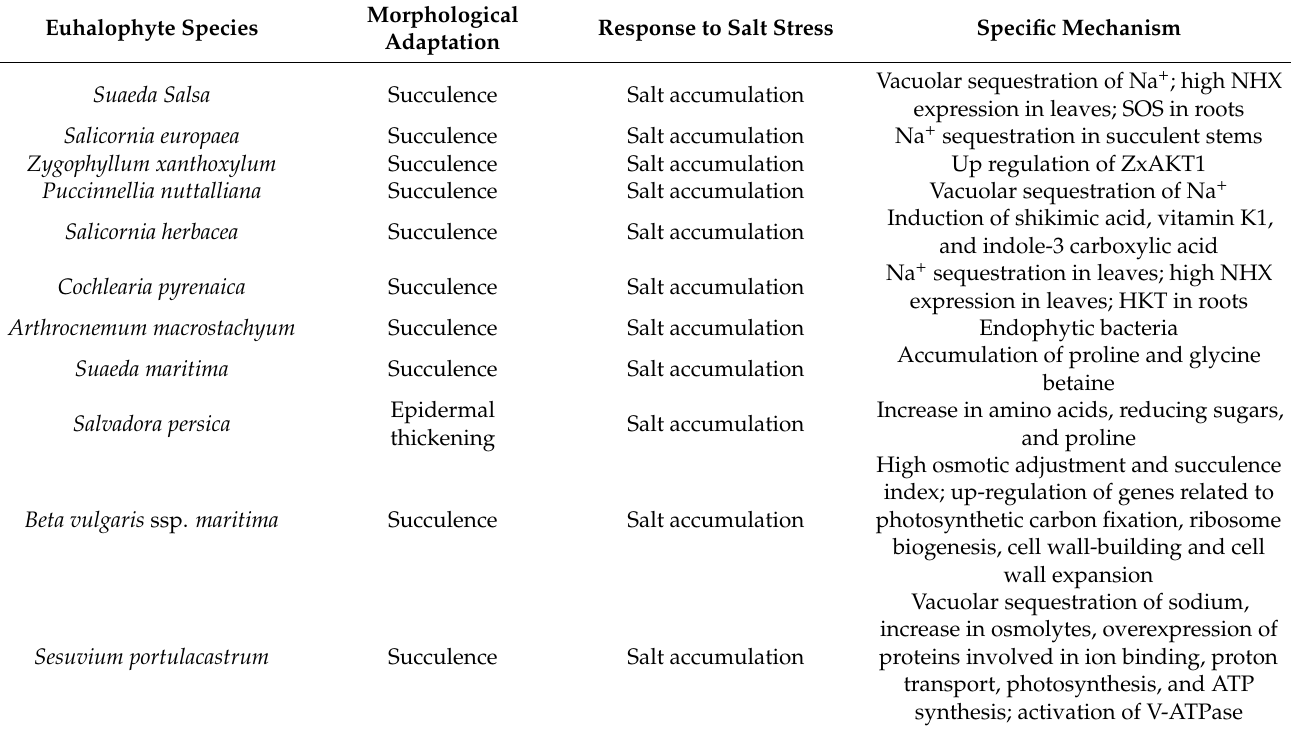
Table 1. Salt tolerance mechanism of some euhalophytes